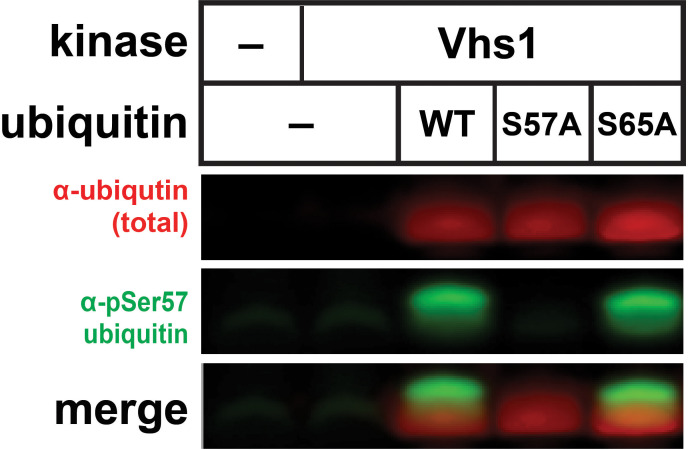
Anti-phospho-Ser57 western blot of E.coli Rosetta 2 (DE3) lysates co-expressing ubiquitin (wildtype, S57A, or S65A) and Vhs1.